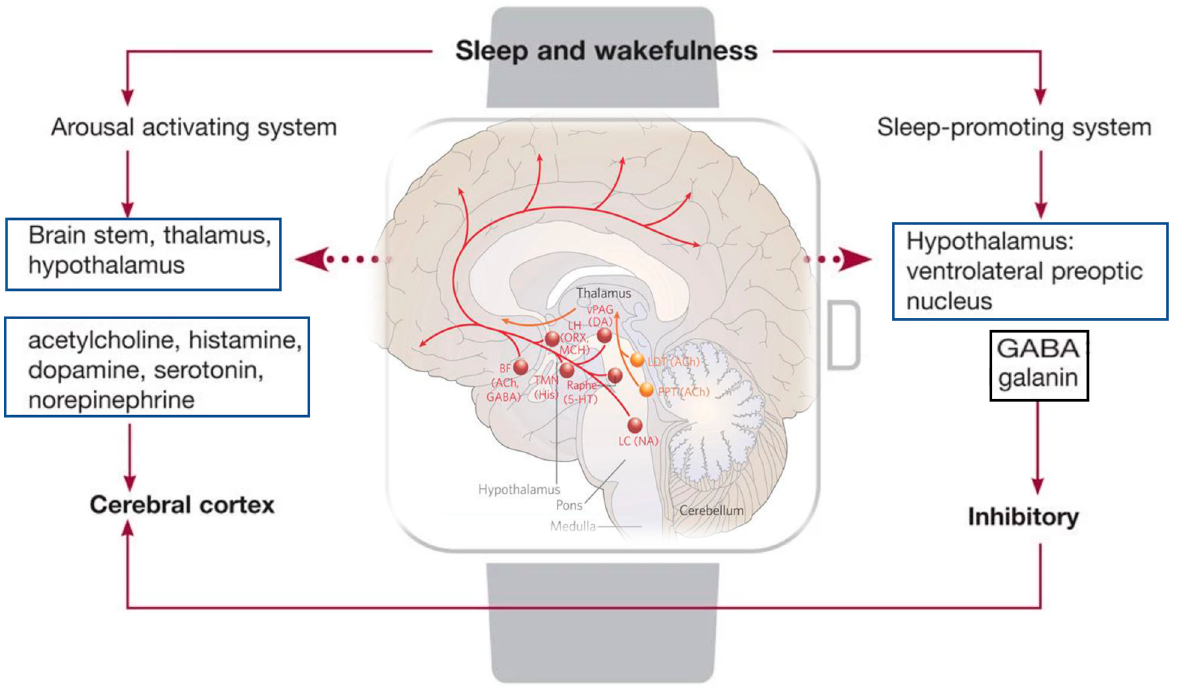
Figure 2. Structures and neurotransmitters responsible for arousal and sleep. In the figure: regulation of the ascending arousal system by the hypothalamic. Red lines represent the pathway of activation of the cortex, to enable the handling of inputs from the thalamus. The monoaminergic structures involved in this process are the locus coeruleus (LC), by noradrenaline (NA); the dorsal and median raphe nuclei, by serotonin (5-HT); the A10 cell group, by dopamine (DA); and the tuberomammillary nucleus (TMN), by histamine (His). Moreover, peptidergic structures are involved, such as the lateral hypothalamus (LHA), by orexin (ORX), or melanin-concentrating hormone (MCH) and basal forebrain (BF) neurons that contain γ -aminobutyric acid (GABA) or acetylcholine (Ach). The orange lane represents the input to the thalamus from cholinergic (ACh) structures, such as the upper pons, the pedunculopontine (PPT), and laterodorsal tegmental nuclei (LDT).